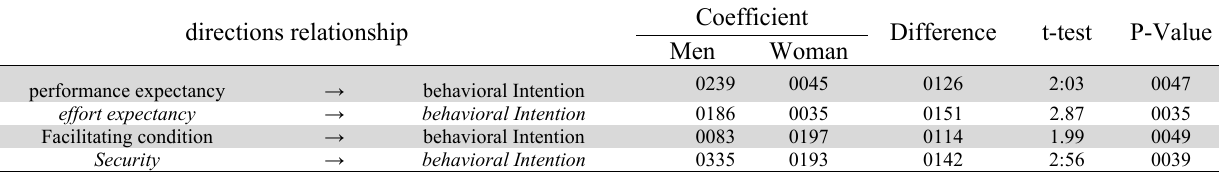
Influence Coefficients gender as moderating variables of Performance Expectancy, Effort Expectancy, Facilitating Condition, Security on Behavioral